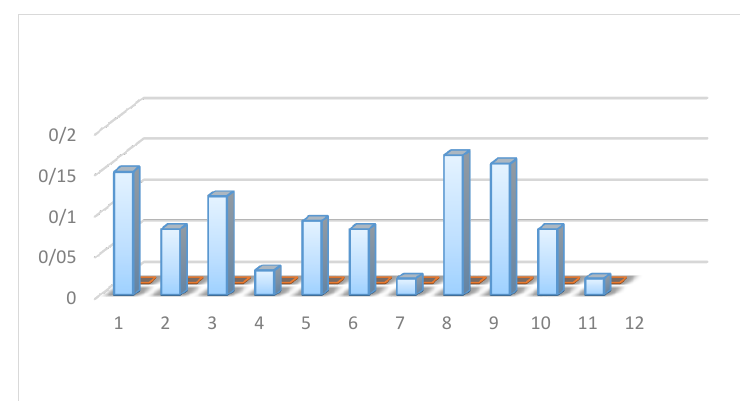
Fig. 2. Graphical behavior of the above mentioned weights to the